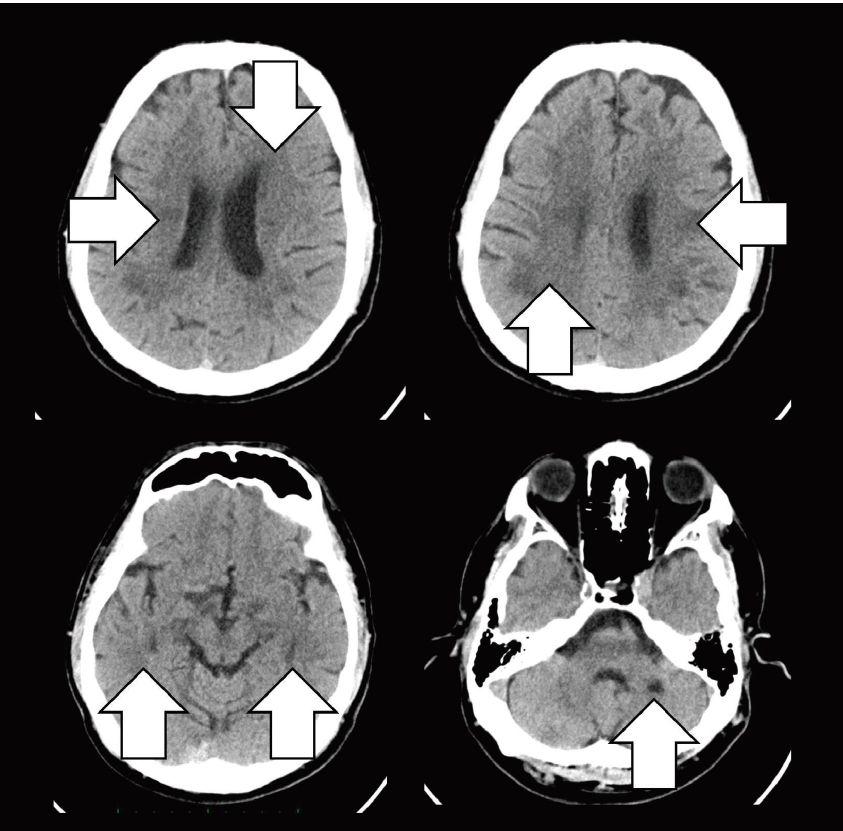
Figure 1: Solid arrows show multiple hypodense lesions of the white matter, which suggest an infarction on the CT